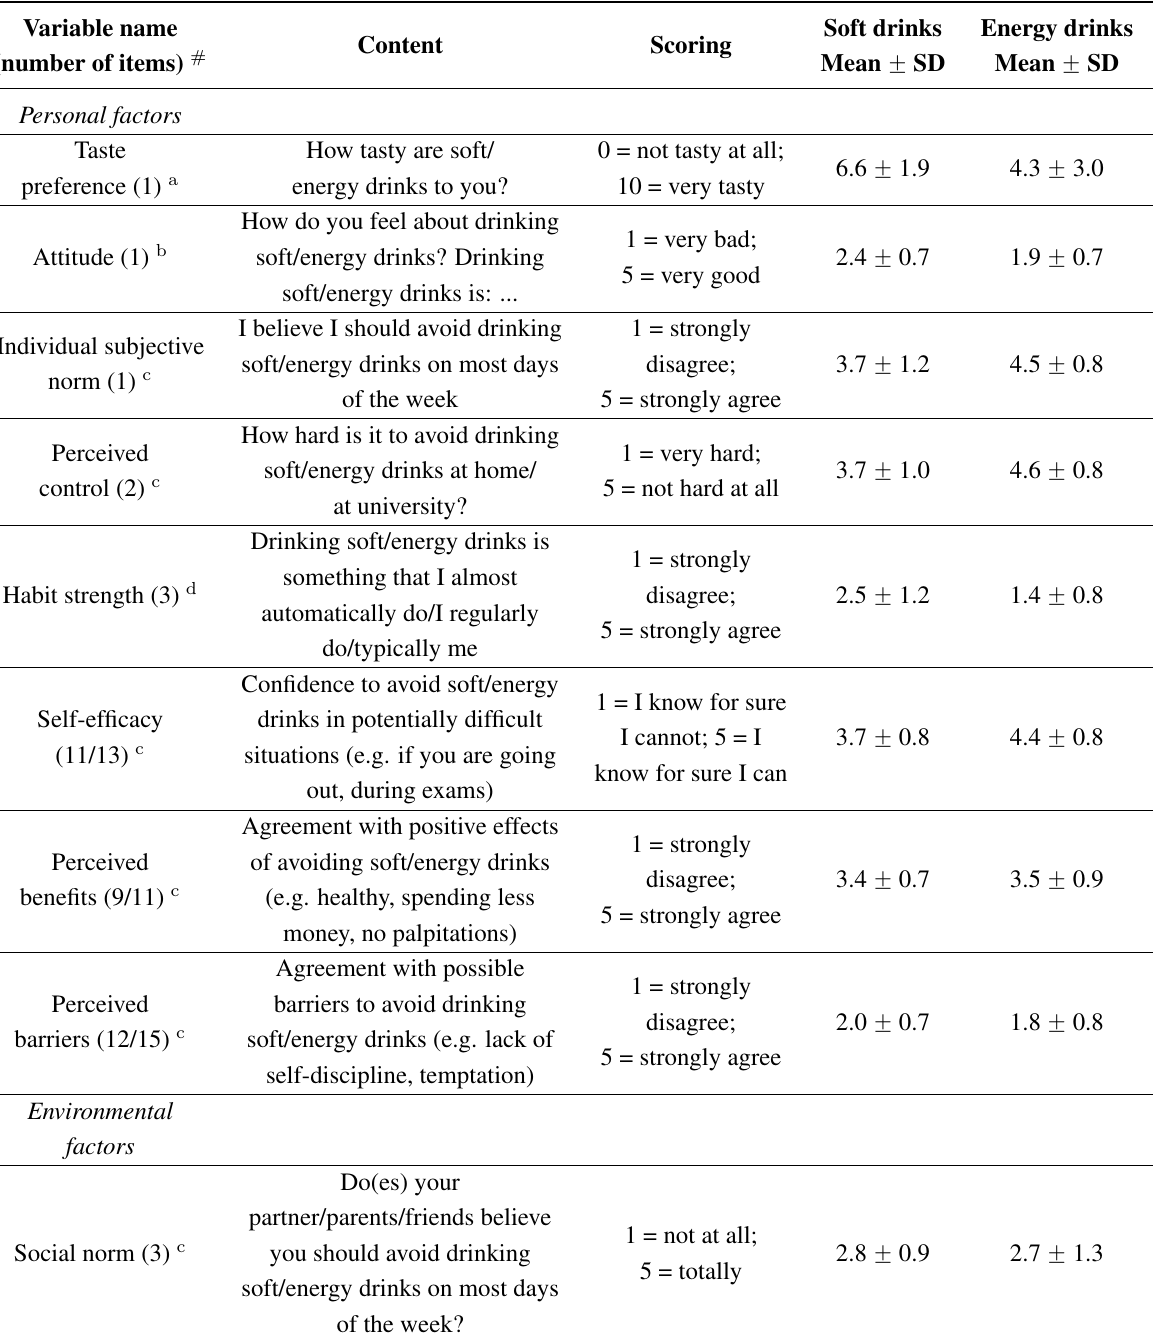
Table 2. Personal and environmental factors of soft and energy drink consumption (Mean ˘ SD; n =